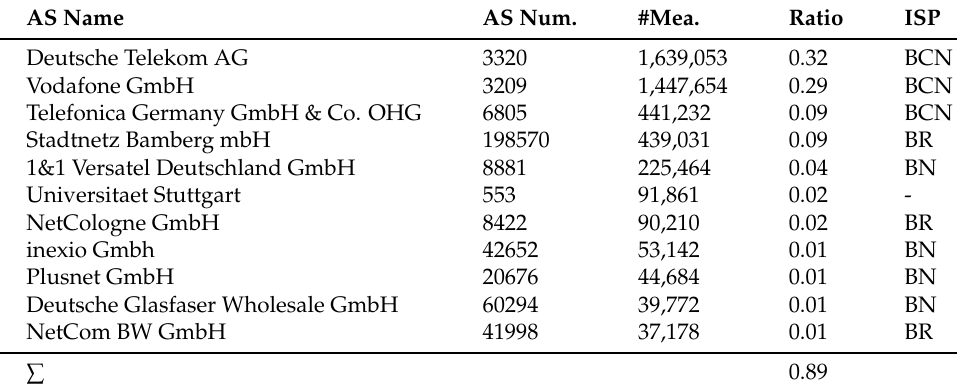
Table 3. Ten most seen ASNs at Frankfurt location in August 2021, note that we do not count the University of Stuttgart as an ISP.